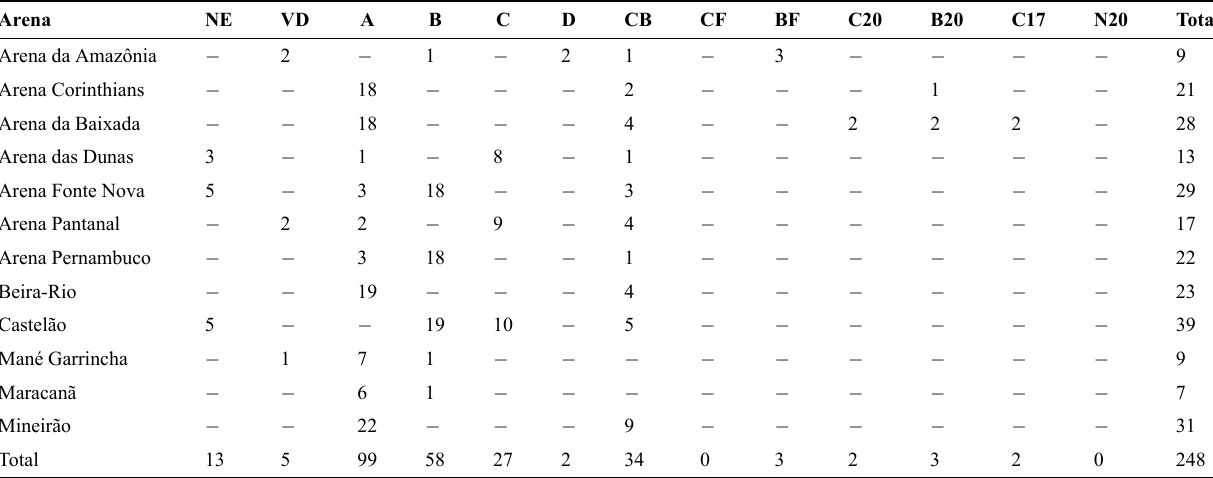
Table 4 - Arena usage in the 2016 season. Arena